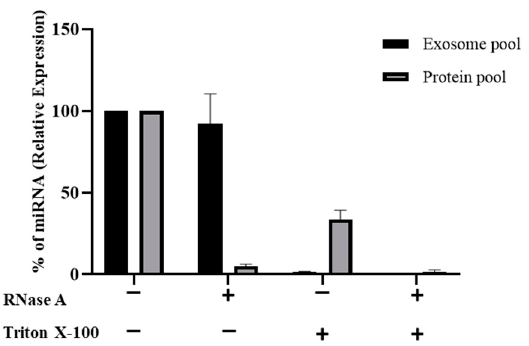
Figure 3. RNase protection assay. The survival percentage of mimic miR-148a-3p was quantified by RT-qPCR in exosome and protein pooled samples treated with RNase A, Triton X-100, or both. Results are expressed in percentage of protected miRNA compared to the respective control.